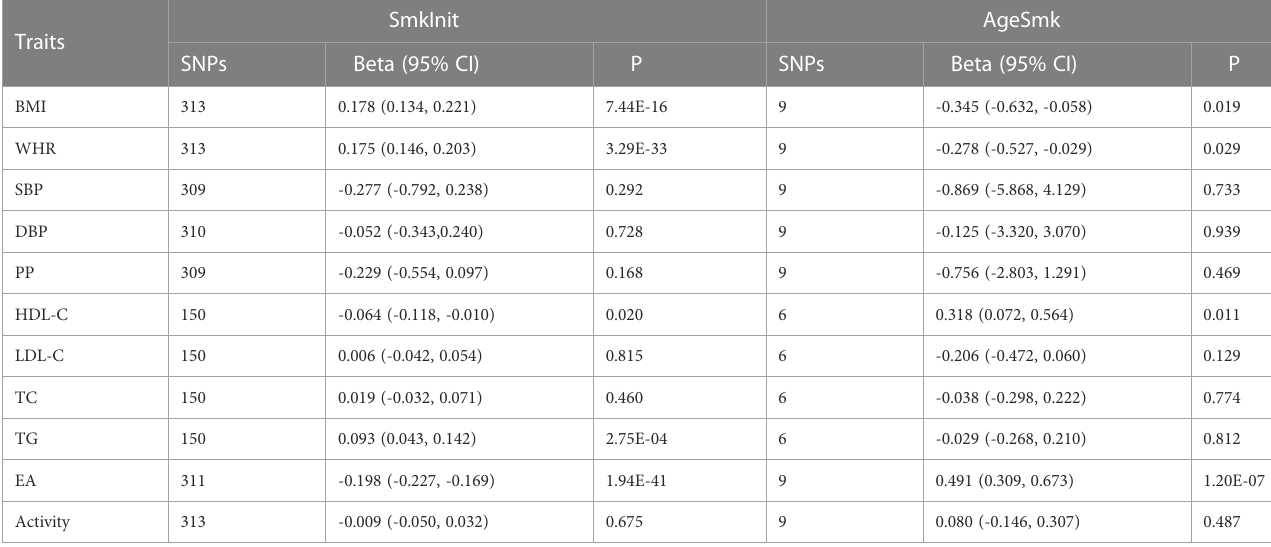
TABLE 2 Association of smoking initiation and age at initiation of regular smoking with cardiovascular risk factors.